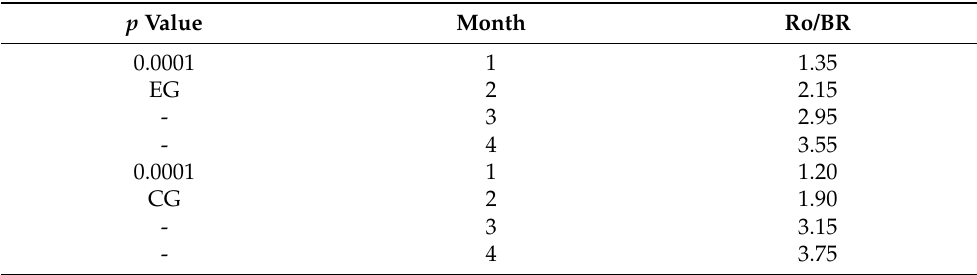
Table 2. Intra-group Friedman’s non-parametric test statistical result throughout 1–4 months post-extraction.